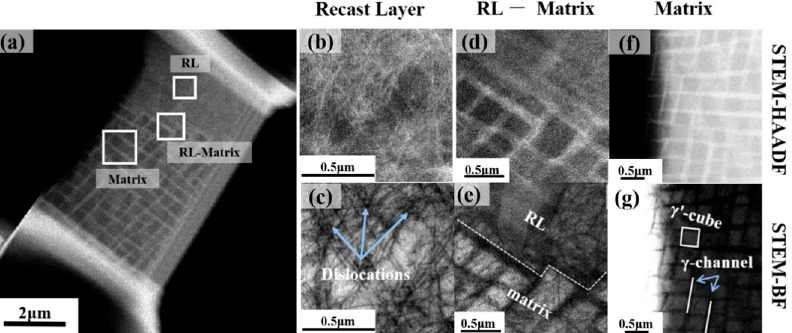
Figure 2. The detailed TEM analysis for the prepared sample: ( a ) The STEM-HAADF image of the overall microstructure. STEM-HAADF and STEM-BF images of ( b , c ) the recast layer, ( d , e ) the recast layer (RL) and matrix transition area and ( f , g ) the matrix of the sample. High-density dislocations are distributed over the area of the recast layer, while the matrix shows a typical γ ’- γ microstructure.